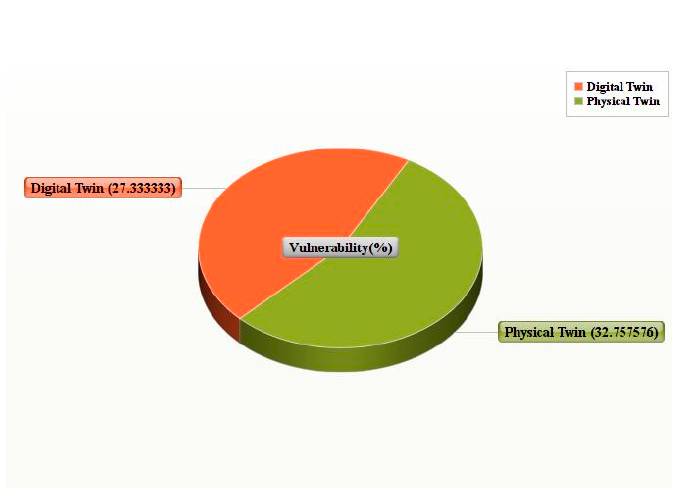
Figure 12. The RMS value based on the digital twin model.